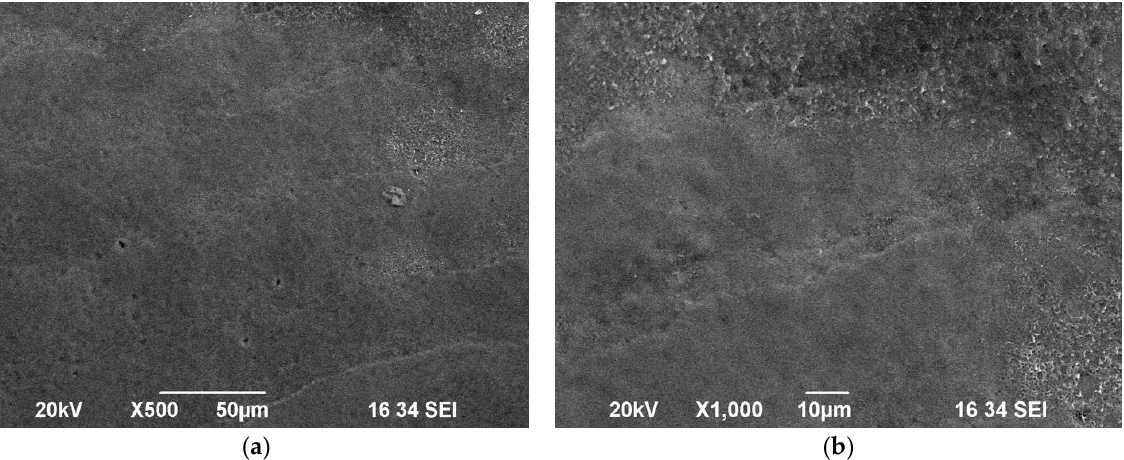
Figure 3. SEM images of tooth surface irradiated with 0.6 W/15 Hz/40 mJ/10 J/cm 2 with 100% water spray—Group C—under ×500 magnification ( a ) and ×1000 magnification ( b ). Observation of intact enamel surface morphology, showing striae of Retzius.